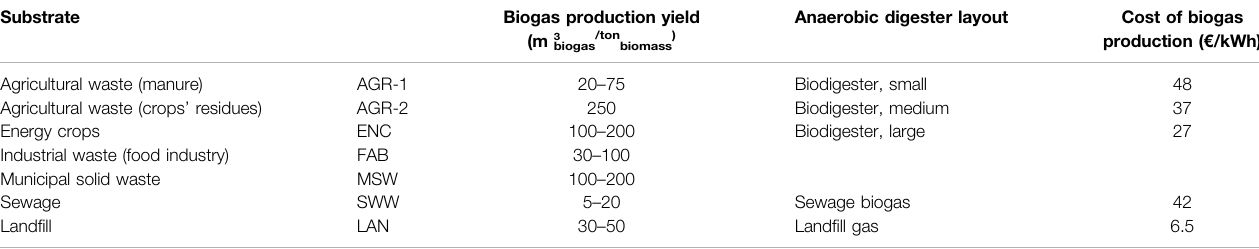
TABLE 1| Biogas production yield from differentfeedstocksand biogasproduction costs depending on the plant layout. Adapted from (International EnergyAgency, 2020; Gandiglio and Lanzini, 2021). Substrate